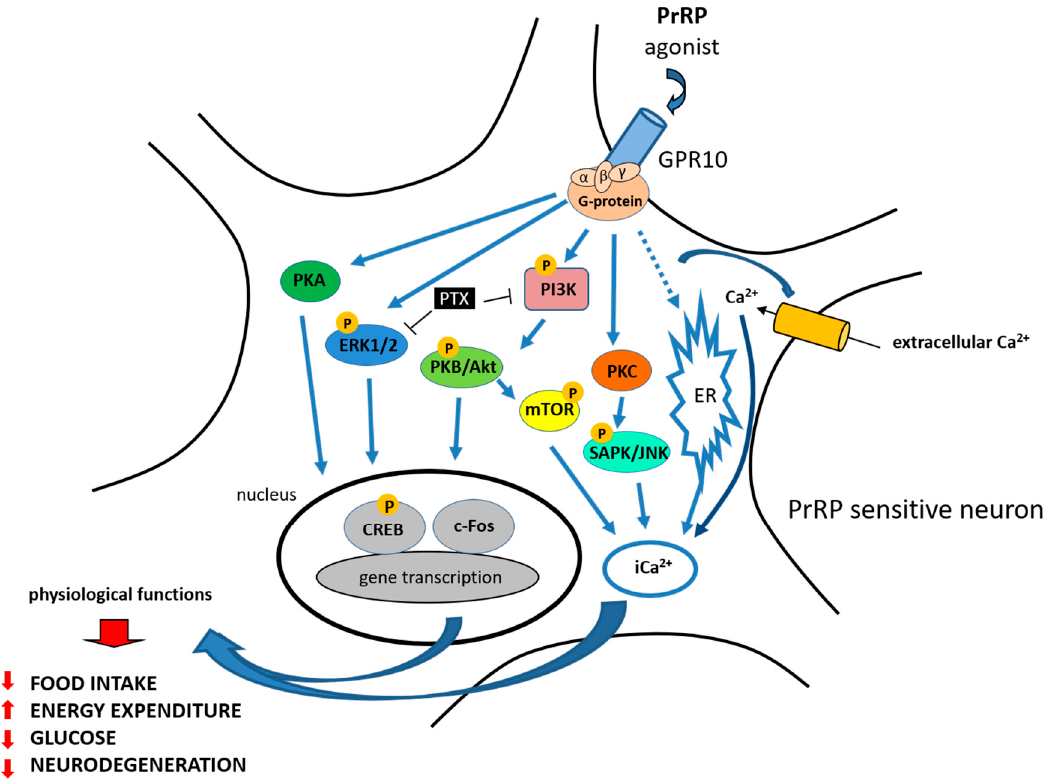
Figure 2. PrRP physiological functions and signaling—summary. PrRP and its agonist exerts its effect through GPR10. Blue arrow represents activation of the signaling pathway, T-bar represents blocking of the signaling pathway. PrRP stimulated calcium release (Ca 2+ ) in calcium mobilization assay and rapidly activated extracellular signal-regulated protein kinase (ERK – blue). It also activated c-Jun N-terminal protein kinase (JNK—light blue) and phosphorylated cAMP response element-binding protein (CREB—grey). Pertussis toxin (PTX—black) blocked the ERK and Akt activation induced by PrRP. PrRP activated the PI3K B / Akt-mammalian target of rapamycin (PI3K-Akt-mTOR) pathways in leiomyoma cells (PI3K—pink, PKB / Akt—green,.mTOR—yellow). PrRP significantly stimulated both the PKA (dark green) and PKC (orange)